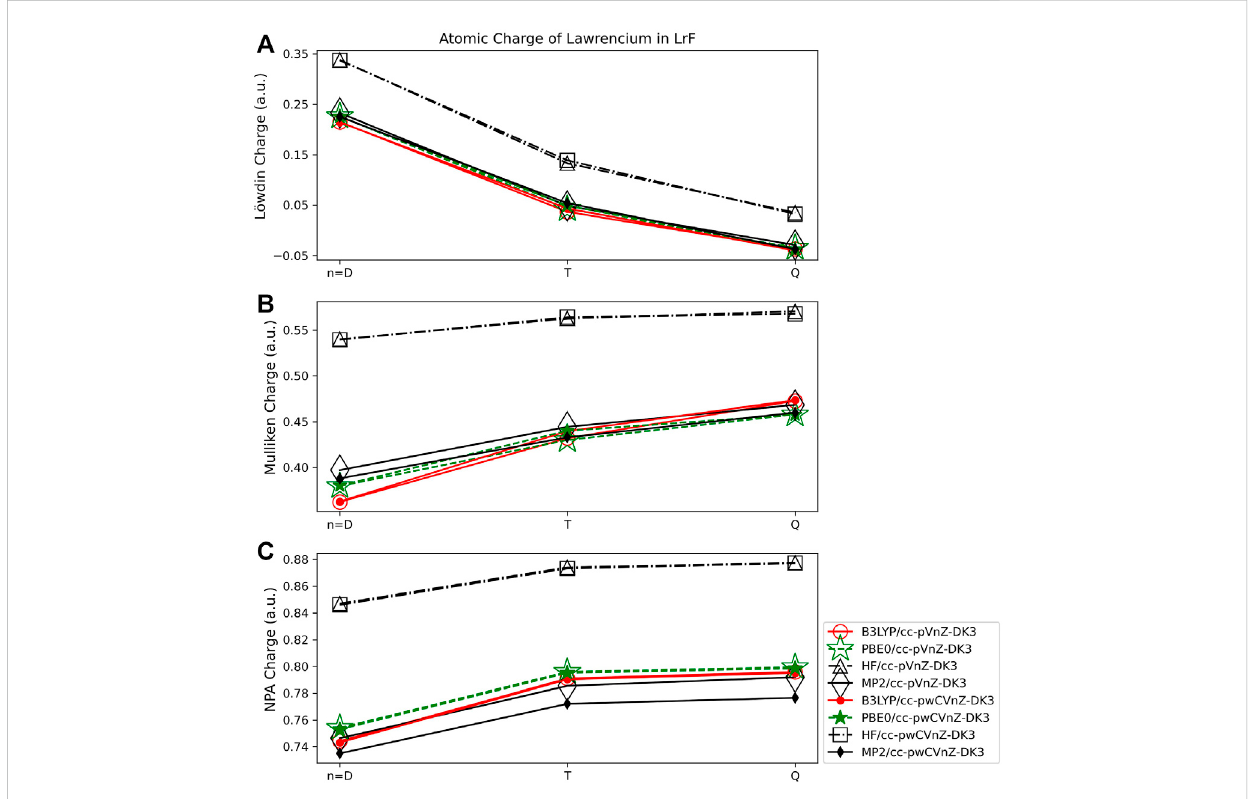
FIGURE 10 Atomic chargeoflawrencium inLrFdetermined usinganumberofdifferenttheoretical methods, Dunning stylebasis sets,andwavefunction-based population analysis methods: (A) Löwdin, (B) Mulliken, and (C) NPA (*Note that scales vary from one analysis method to another.).